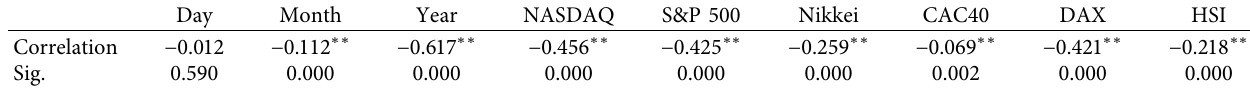
Table 5: Correlation between ASEI and international indices.